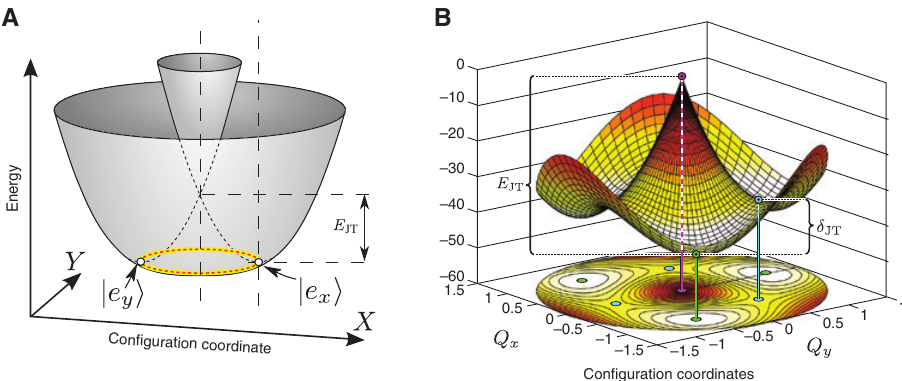
is the Jahn- JT ) among the three minima JT x and e vibration mode of = 77.6 meV, x y